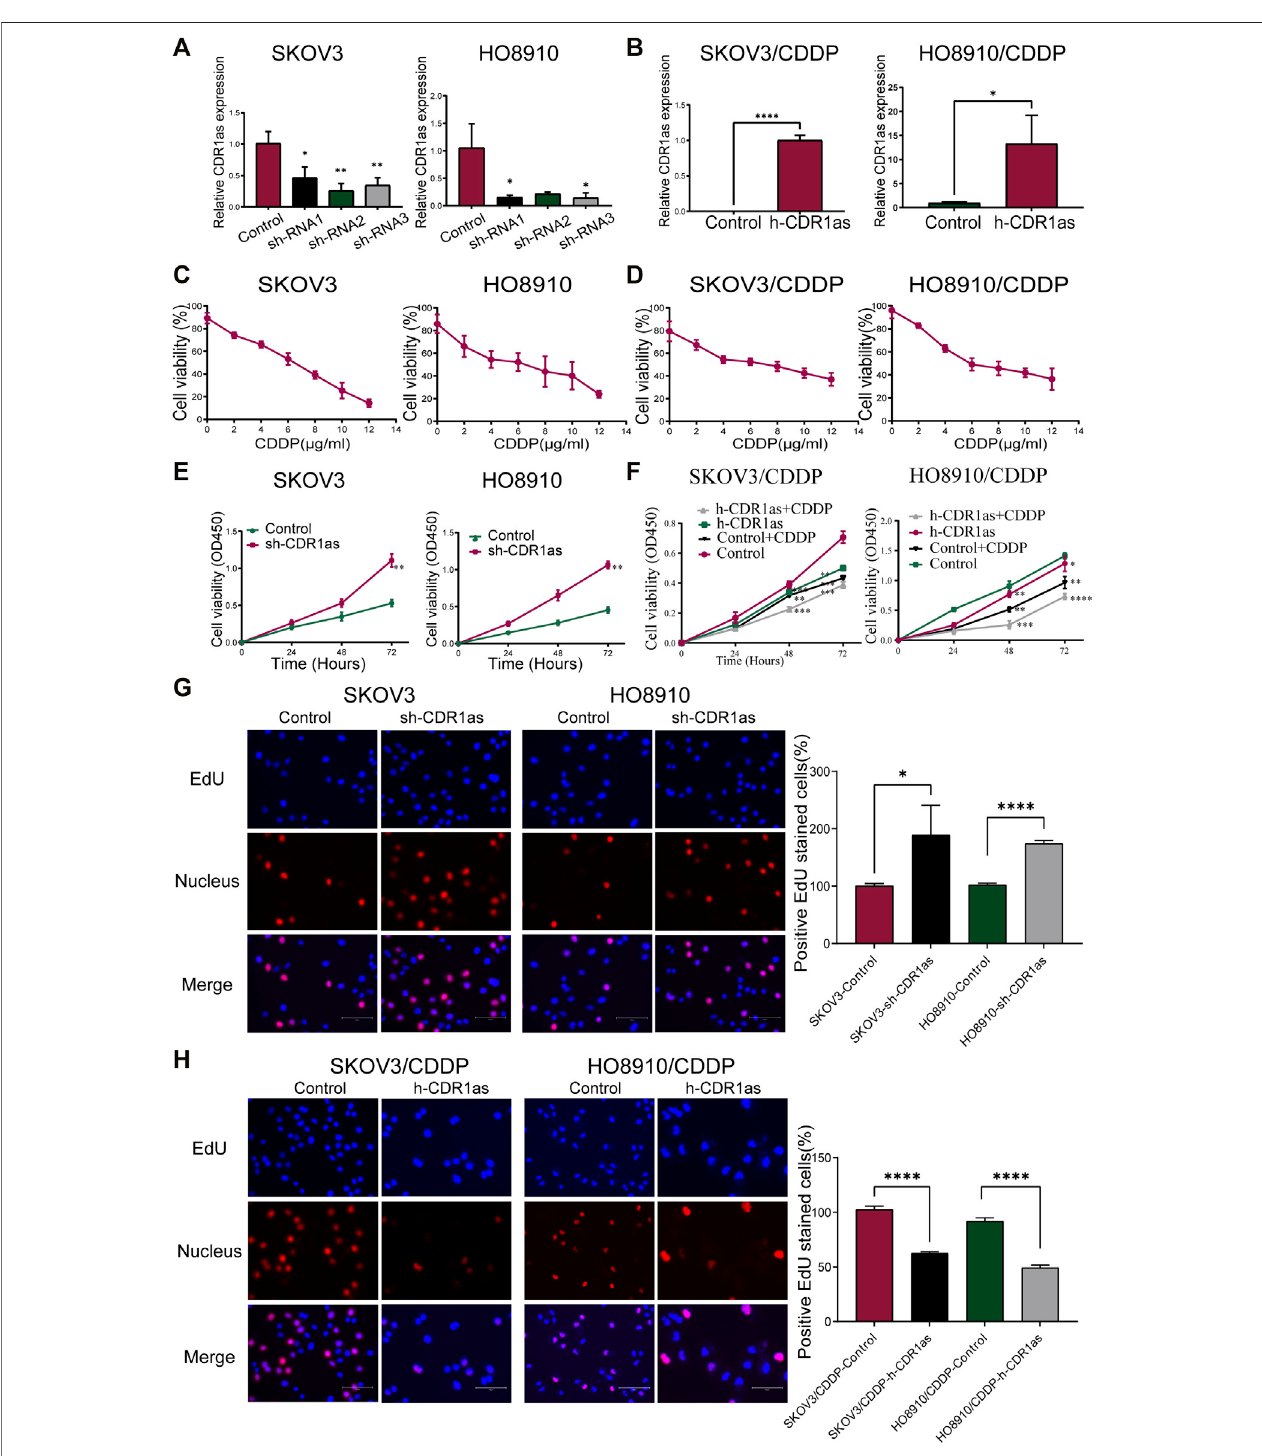
FIGURE 2 | CDR1as suppresses the cell proliferation in vitro . (A,B) Veri fi cation the ef fi ciency of downregulated CDR1as in SKOV3 and HO8910 cells (A) and overexpressed CDR1as in SKOV3/CDDP and HO8910/CDDP cells (B) by qRT-PCR. (C,D) MTT determined the IC50 of CDDP. (E,F) CCK-8 assays detected the cell proliferation of CDDP-sensitive (E) and -resistant OC cells (F) in the presence of CDDP. (G,H) EdU assays were performed to identify the cell proliferation of transfected CDDP-sensitive (G) and -resistant OC cells (H) . These results were presented as the mean ± SDs. * p < 0.05, ** p < 0.01, *** p < 0.001 and **** p < 0.0001.